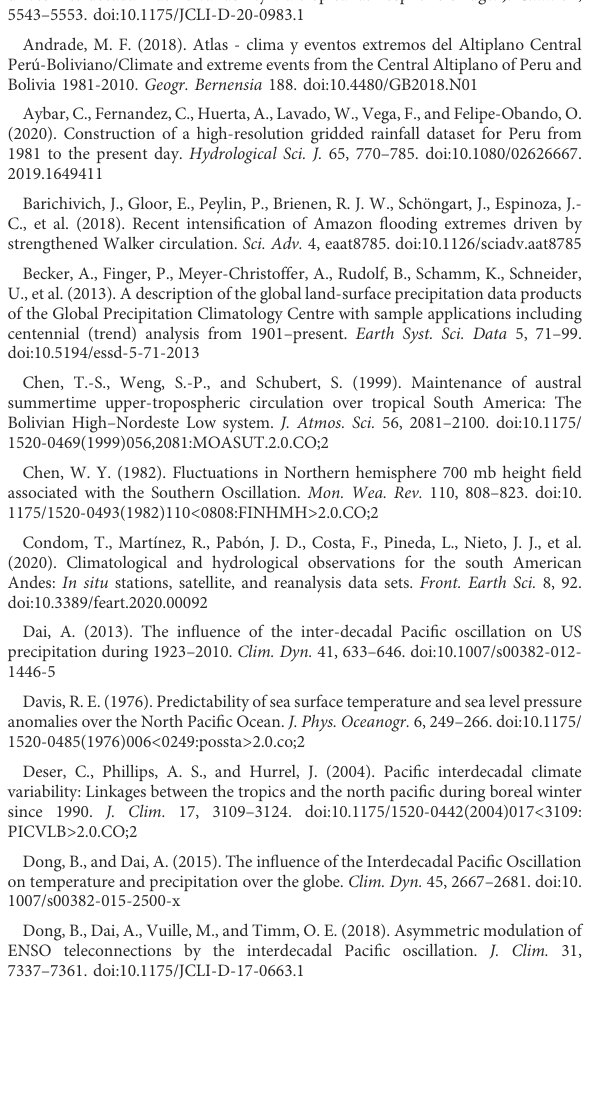
SUPPLEMENTARY FIGURE S1 Spatial correlation of interdecadal component of the sea level pressure (ISLP) anomalies with the Interdecadal 1179 North Atlantic Oscillation (INAO) index. The analysis is based on austral summer (December- January-February, DJF) 1180 averages for the 1921 – 2010 period. Hatching represents a statistically signi fi cant correlation at the 95% con fi dence